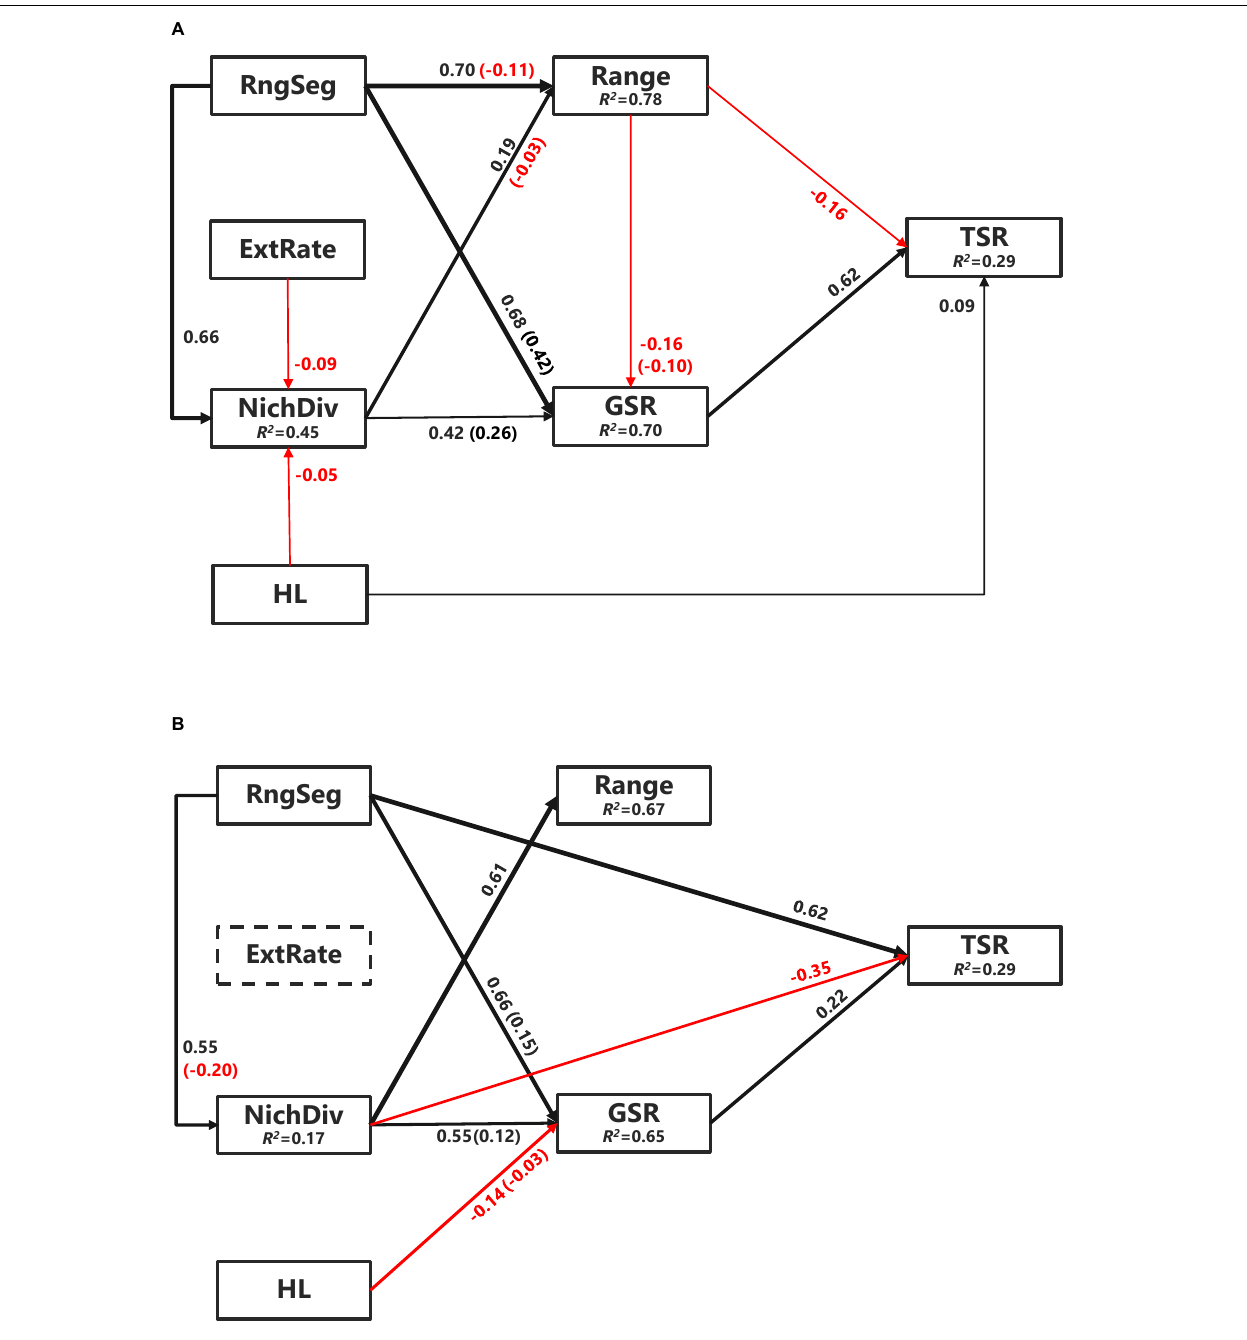
FIGURE 4 | Piecewise structural equation modeling (SEM) models of TSR of Chinese angiosperm genera (A) and endemic genera (B) . Black arrows denote positive relationships and red arrows denote negative relationships. Non-significant paths ( P ≥ 0.05) are not shown to keep simplicity. The thickness of the significant paths has been scaled based on the magnitude of the standardized regression coefficient. R 2 s for component models are given in the boxes of response variables. Values in parentheses are the indirect effects strength on TSR. NichDiv, genus niche divergence; RngSeg, range segregation; ExtRate, relative extinction rate; HL, habitat loss; GSR, genus species